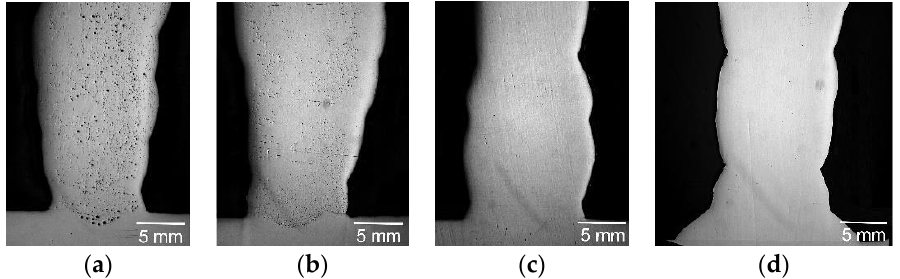
Figure 8. The optical macrostructure of the multilayer weld deposition: ( a ) 316L wire; ( b ) 316L wire with Ni-LaB 6 coating; ( c ) G3Si1 wire; ( d ) G3Si1 wire with Ni-LaF 3 coating of 6 μm in thickness.